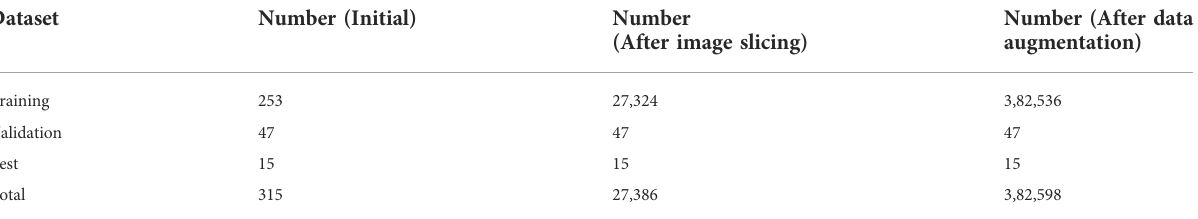
TABLE 2 Details of the rock